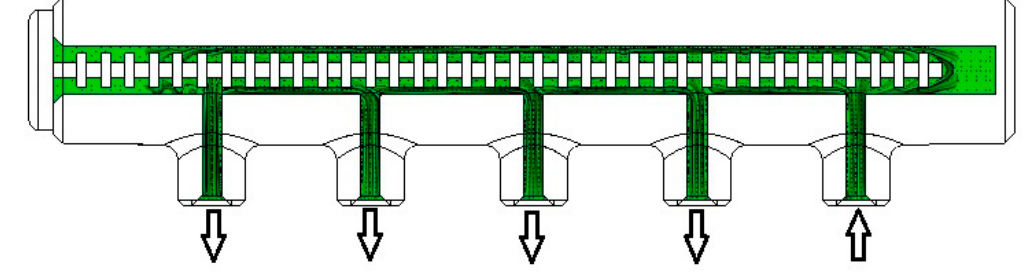
Figure 5. Simulation of fuel flow through CR.